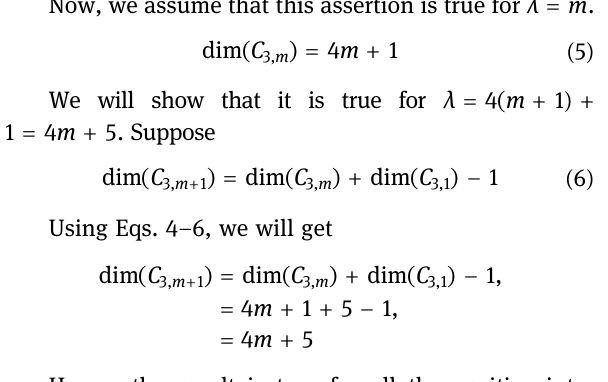
Hence, the result is true for all the positive inte - gers λ ≥ 1.